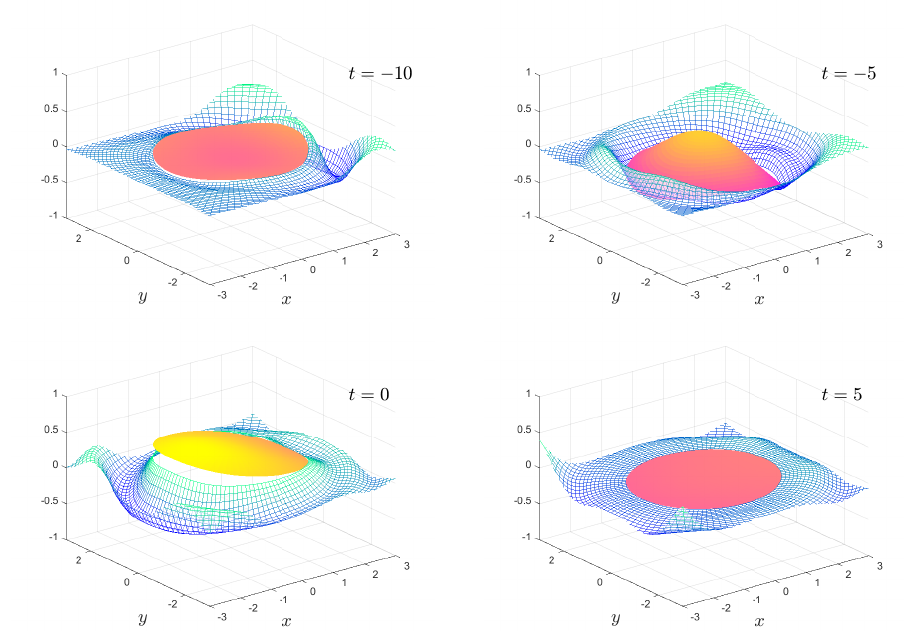
Figure 7. As in Figure 6, except β = 1 × 10 − 3 . The full animation can be found in movie 6.